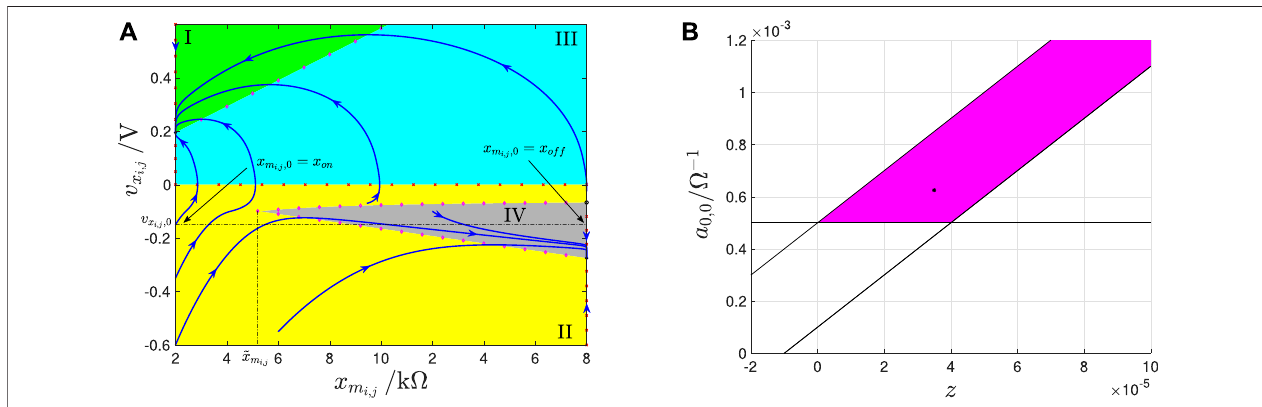
FIGURE 19 | (A) SDP of the bistable cell C ( i , j ) of the isolated and autonomous RECALL M-CNN. Choosing a suitable value for the initial condition v x on the capacitor i , j , 0 , v ) evolvesintime voltage,here − 0 . 15V,ifthememristorsitsinthehighest(lowest)possibleresistivestate x off ( x on )attheonsetofthedatarecallprocedure,thestatevector ( x m x i , j i , j < ( > ) − (+) v toward the equilibrium (39) ((45)) located in the phase-plane region v x sat , as expected from rule 1 (2) from Table 6 . Importantly, since the memristor state x m i , j at i , j equilibrium is found to be identical as its initial condition x m , the data stored in the locally distributed memristive memory bank are unaltered by the RECALL operation. i , j , 0 Importantly,thevaluesoftheself-feedbacksynapticweight a 0 , 0 andoftheoffsetcurrent i w intheSDPidentifyapointlocatedinthepinkdomainoftheM-CNNPrimaryMosaicof i , j Figure13 . (B) Graphicalillustrationofthegeometricanalysis,carriedoutintheparameterplane z – a 0 , 0 ,forthedeterminationofvalidsolutionsofthenon-redundantinequalitytrio, composedofconditions Eqs.55 , 66 ,and 67 .Thesethreeinequalities,obtainedthroughthesystem-theoreticmethodology,proposedin section3.3 ,allowtomassagetheDRM 2 of each M-CNN processing element in such a way to retrieve the information stored in the memristor M x . On the basis of Table 3 , and setting G x to 0 Ω − 1 , they are found to i , j feature formulas a 0 , 0 > 5 · 10 − 4 Ω − 1 , a 0 , 0 > ( 10 · z + 1 · 10 − 4 ) Ω − 1 , and a 0 , 0 < ( 10 · z + 5 · 10 − 4 ) Ω − 1 , respectively. The coordinates of each point ( z , a 0 , 0 ) within the magenta domain satisfy them concurrently. The cell SDP, depicted in plot (A) , was derived for the particular solution ( z * , a * 0 , 0 ) (cid:1) ( 3 . 5 · 10 − 5 , 6 . 25 · 10 − 4 Ω − 1 ) , which, as indicated via an asterisk marker in plot (B) , resides, to some extent, away from the white parameter plane region, where at least one of the three conditions does not hold